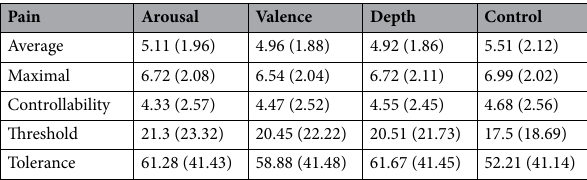
Table 1. Means and standard deviations of pain